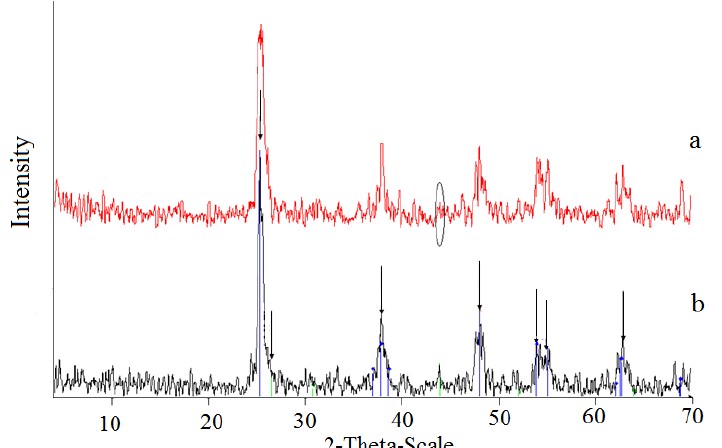
Fig. 2. XRD patterns of CdS-TiO 2 -Tyrosine (a) after calcination (b) without calcinations.